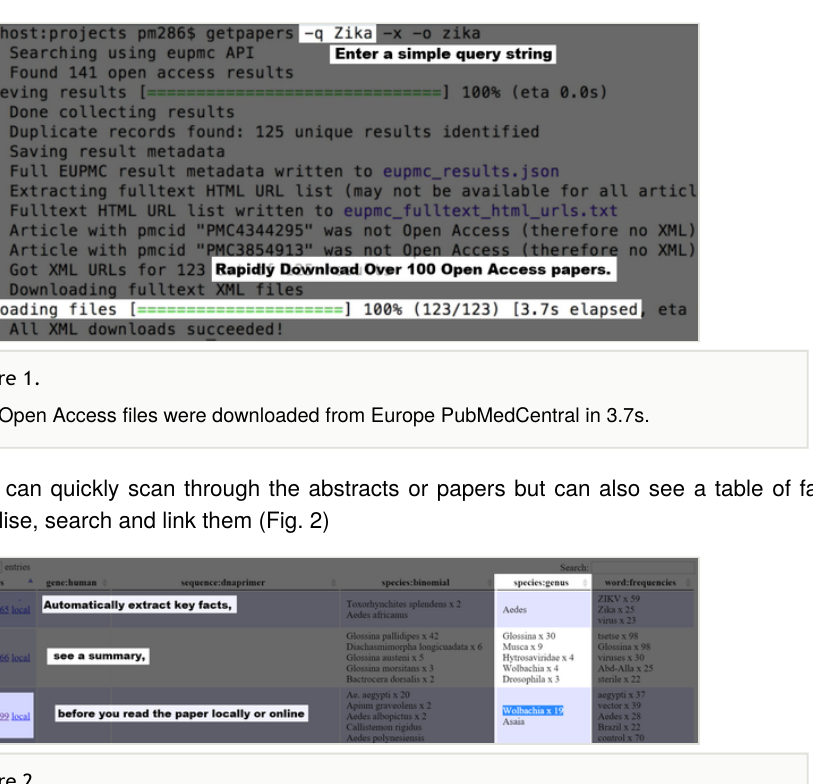
A data table showing facts extracted from the 123 papers, including species, human genes, DNA primers and top word